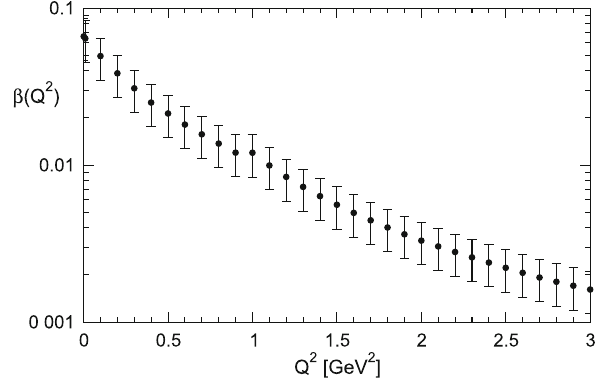
Fig. 1 Residue of the leading Reggeon contribution (9) ( Q 2 ) defined in (11) as a function of Q 2 for Table 1 Lower bound δ R 0 several values of W h Q 2 W h =